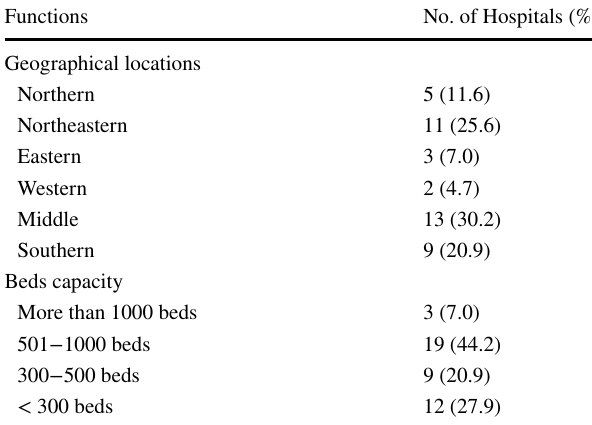
Table 1 Characteristics of the 43 surveyed Thai hospitals